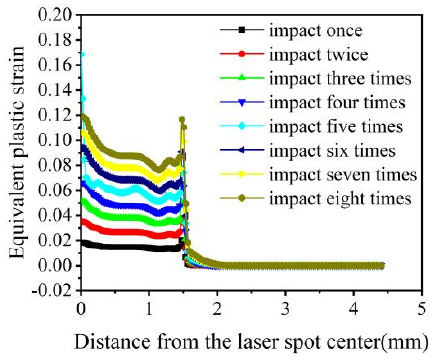
Figure 13. Equivalent plastic strain of 20CrMnTi for different impact numbers.